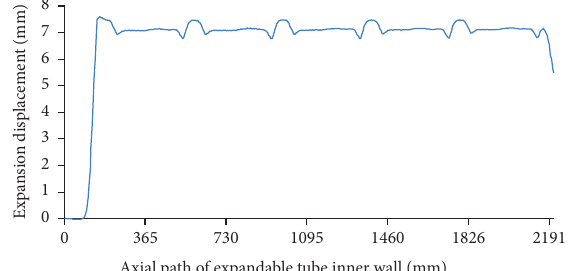
Figure 7: Relation between the radial displacement of the ex- pandable tube inner wall and the axial path of the expandable tube.